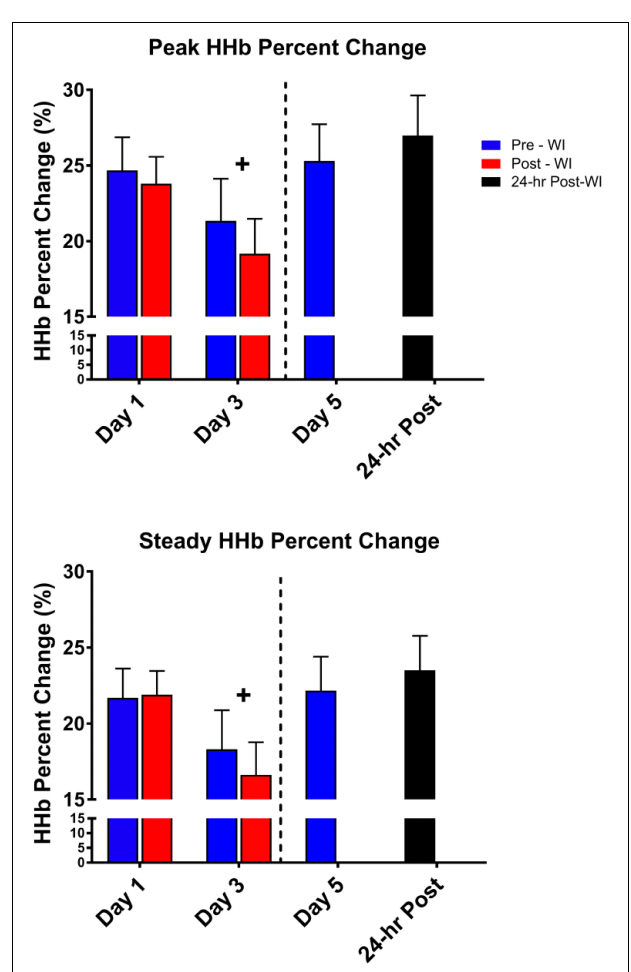
FIGURE 6 | Fifty-repetition maximal IK knee extension NIRS results. Across subject ( n = 13) mean ± SEM is shown. HHb concentrations were lowest on WI 3. “ + ” signifies day main effect ( p <